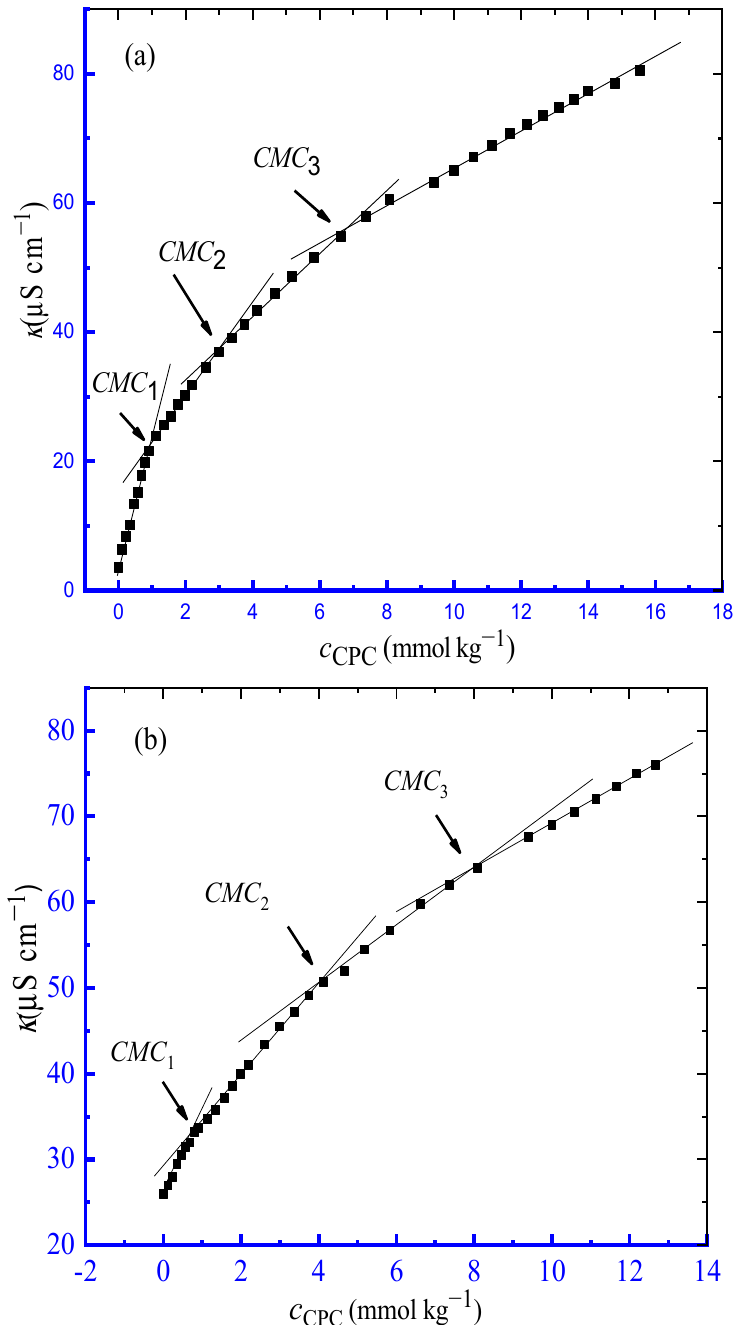
Figure 1. Specific conductivity ( κ ) versus CPC concentration plot for the CPC + 0.1% ( w / v ) PVP mixture in ( a ) water and ( b ) aq. 1.50 mmol kg − 1 NaCl solution at 303.15 K. For all the cases of CPC + PVP mixed system, three break points were obtained. The concentration of surfactant achieved at the break point has been taken as the CMC , and the successive CMC values were expressed as CMC 1 , CMC 2 , and CMC 3 , respectively. The CMC 1 can be associated with the formation of the PVP (polymer): CPC complex (critical aggregation concentration); the CMC 2 corresponds to free CPC micellization (critical mi- celle concentration in the presence of PVP), and the third break point ( CMC 3 ) refers to the structural modifications in micelles as a sphere to rod transition [31]. The third critical micelle concentration indicates that the spherical micelle turns into a rod shape. Chakraborty et al. [32] described three CMC s (critical aggregation concentration ( CAC ), polymer saturation concentration ( c s ), and free micellization concentration ( c m* )) for the assembly of the mixture of SCMC and CTAB. Bhattarai has achieved three CMC values for the aggregation of the CTAB + sodium polystyrene sulfonate mixture [33]. In spite of the existence of multiple CMC for an association of polymer + surfactant mixture, a single CMC is also stated in the literature [34–37]. Chai et al. [38] investigated the interaction amid PVP and a gemini surfactant by NMR in a D 2 O medium at 298 K. They confirmed the CMC , С AC , and additive saturated concentration ( C 2 ) by measuring chemical shift and self-diffusion coefficients, respectively. Mukhim and Ismail [39] reported CMC values of 0.841 and 0.75 mmol kg − 1 for the micellization of CPC in water and 0.32 mmol kg − 1 NaCl solution, respectively, at 298 K by means of surface tension measurement technique. The decrease in CMC values in NaCl solution compared to water medium has good agreement with the current study. Varade et al. [40] investigated the impact of electrolyte (NaCl and NaBr) on the CMC value of CPC using different techniques (surface tension/conduct- ance/viscosity/dynamic light scattering (DLS)/small angle neutron scattering). From sur- face tension and conductivity techniques, Varade et al. [40] stated that CMC value of CPC was found to be 0.98 and 0.95 mM, respectively at 303 K and obtained a decrease in CMC value in the occurrence of salt. The DLS study showed that, in presence of electrolytes, the repulsive interactions will cause a rise in the diffusion coefficient and therefore a reduc- tion in the apparent diameter of the micelles, i.e., a decrease in CMC of CPC was observed [40].